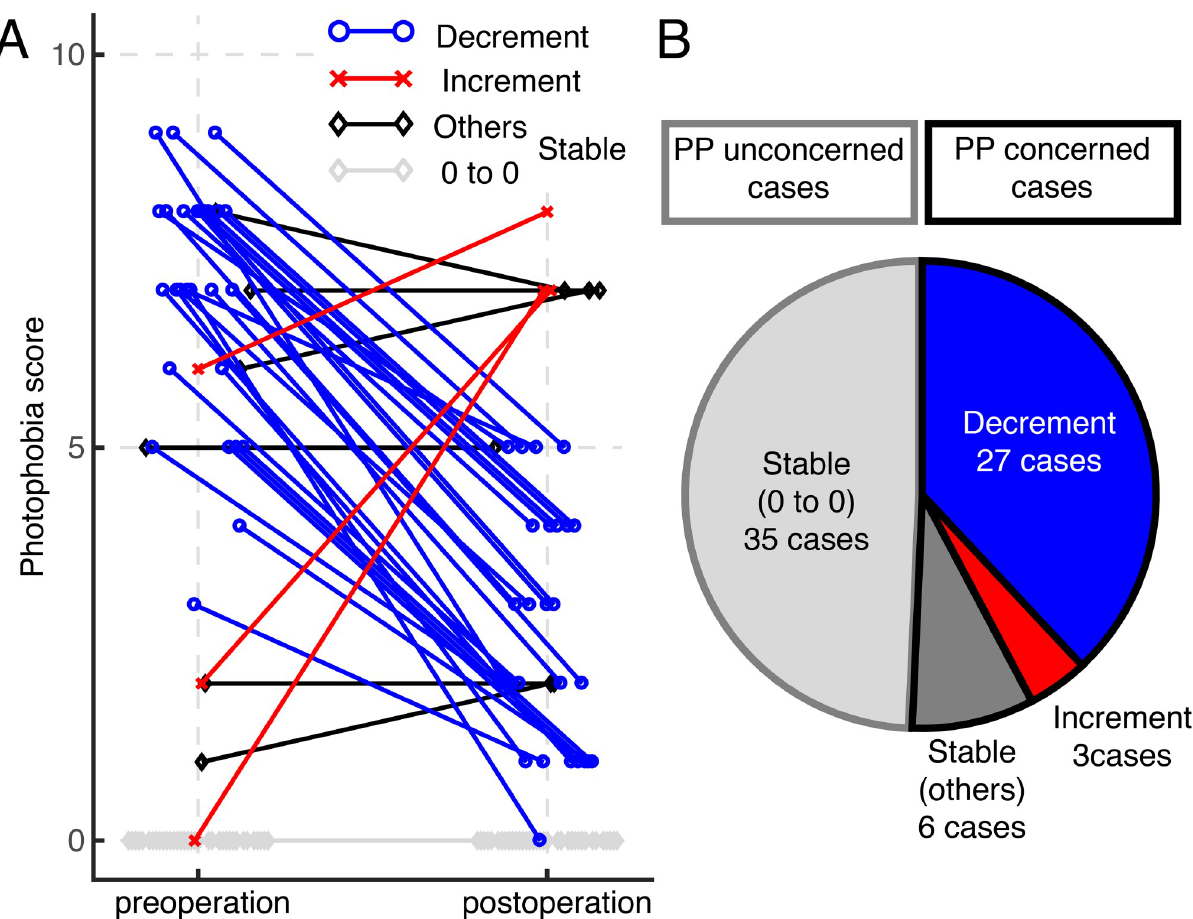
Fig 1. Preoperative and postoperative subjective photophobia scores. Fig 1A shows a line graph indicating raw data of pre- and postoperative photophobia scores in 71 patients. The vertical axis represents photophobia scores, ranging from 0 (patient does not experience photophobia at all) to 10 (patient experiences severe photophobia during eye opening). Decrement cases are shown in blue lines with circles, stable cases in black lines with diamonds, and increment cases in red lines with crosses. Fig 1B shows a pie graph indicating the distribution of each group. Twenty-seven patients belonged to the decrement group, 41 to the stable group, and 3 to the increment group. In the stable group, 35 patients showed a photophobia score of 0 both preoperatively and postoperatively, and were considered PP unconcerned cases (light gray outlined). Meanwhile, the remaining cases were considered PP concerned cases (black out lined).